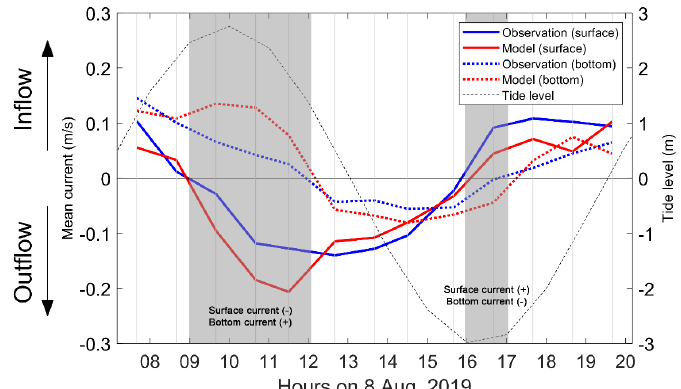
Figure 6. Spatially averaged currents across the North Port. Positive (negative) currents indicate flows toward (away from) the port. The gray vertical lines indicate the time at which the observation was conducted. The gray shades indicate the periods when the directions of the surface and bottom currents were reversed.